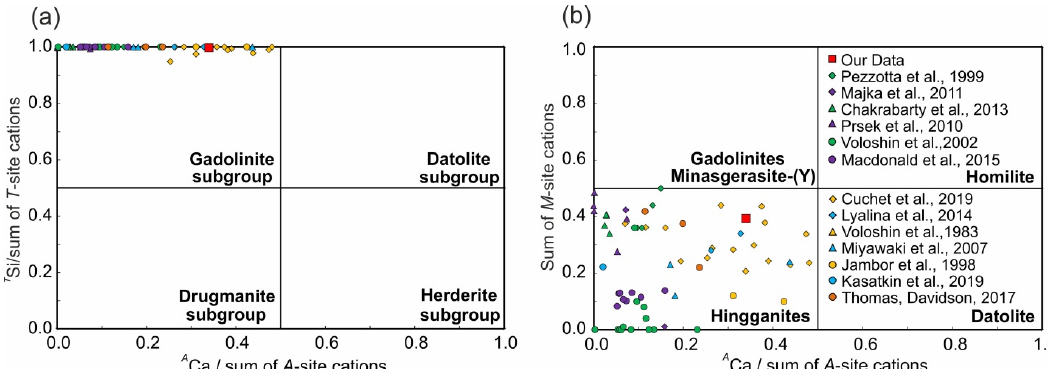
Figure 3. Published data on hingganites from different deposits plotted on classification diagrams of the gadolinite supergroup: ( a ) for determination of groups and subgroups, ( b ) for species determination. The legend for both graphs is given on the (b) graph.